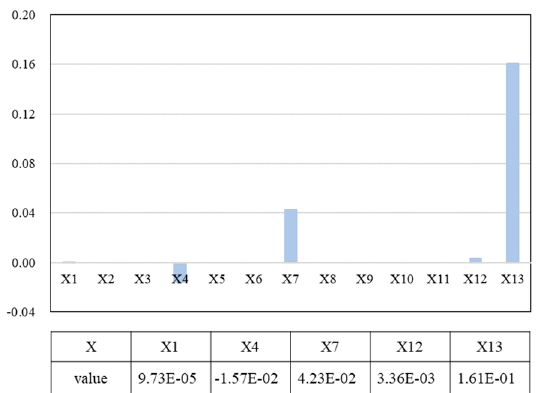
Figure 14. Variable importance with Least Absolute Shrinkage, and Selection Operator (LASSO).